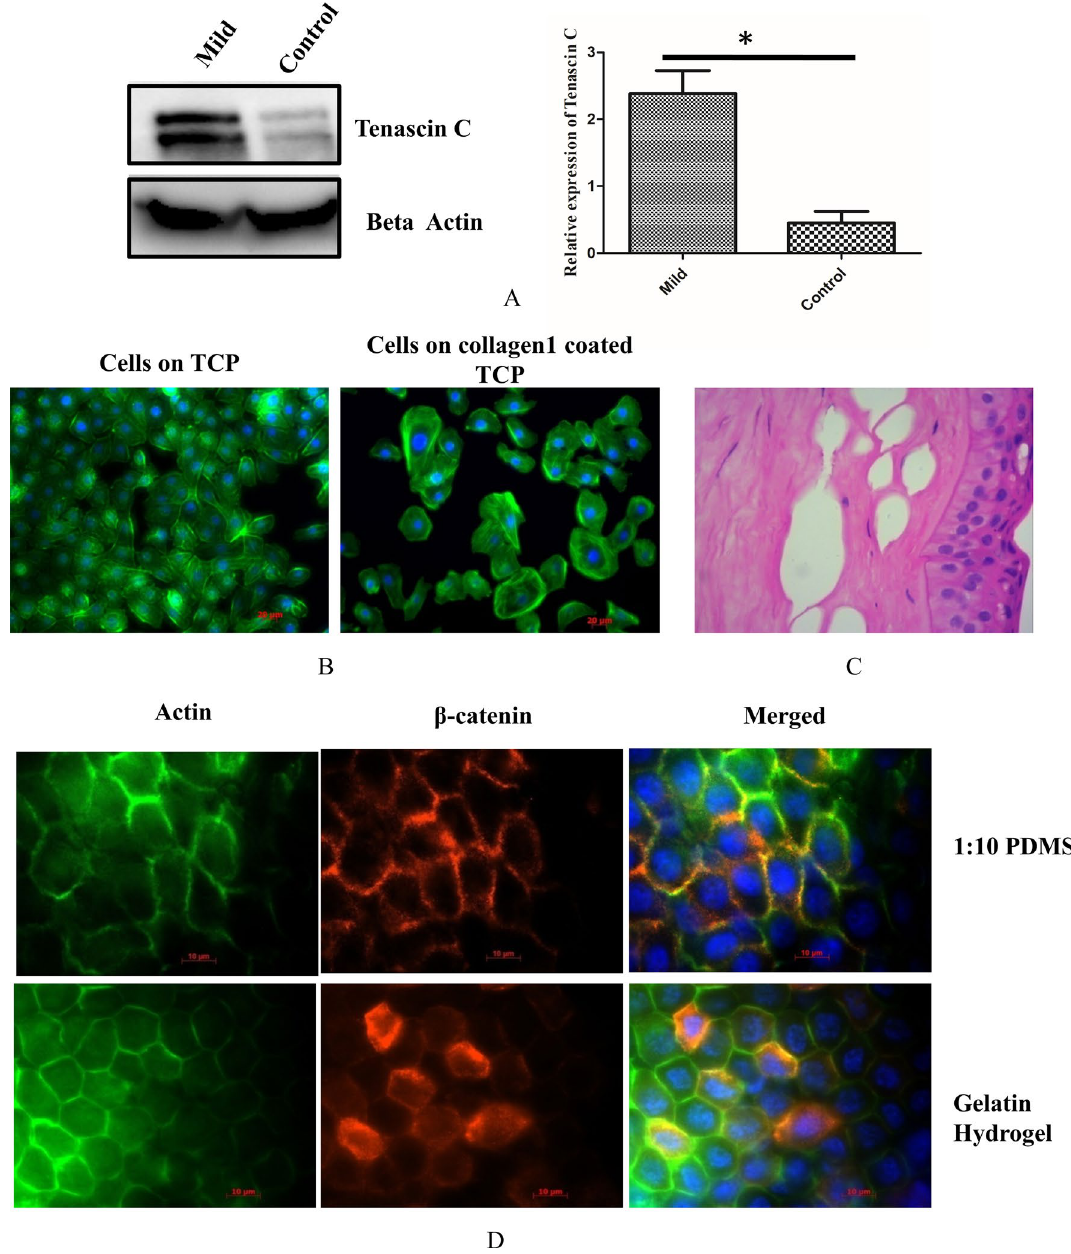
Figure 6. (A) Immunoblotting of Tenascin C in control and mild KC epithelium(n = 3) (Full blot was cut in two halves for probing Tenascin C and beta actin image is represented in Fig S22) (B) Phalloidin staining of corneal epithelial cells on plate with and without collagen coating Scale bar-20 µM (C) Histological section of KC from patients undergoing penetrating Keratoplasty (n = 7) (D) β-catenin localization of epithelial graft cultured on 1:10 PDMS and Gelatin Hydrogel Scale bar-10